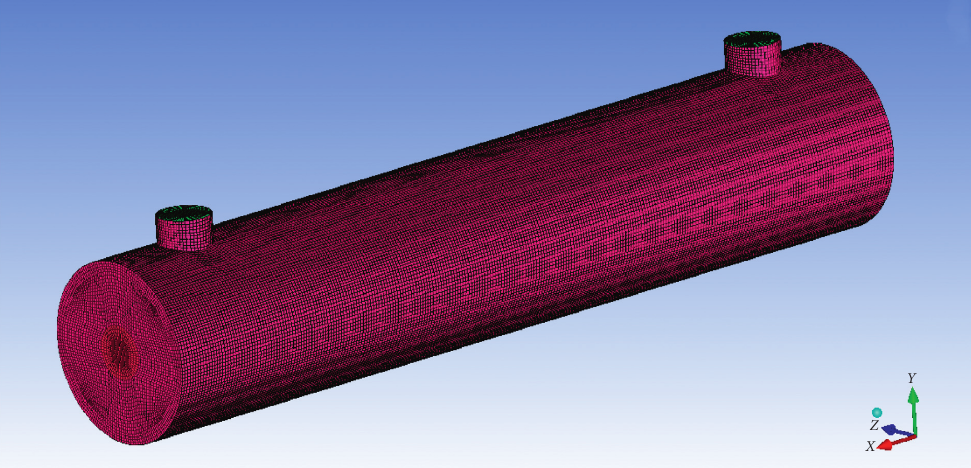
Figure 4: The resulting mesh